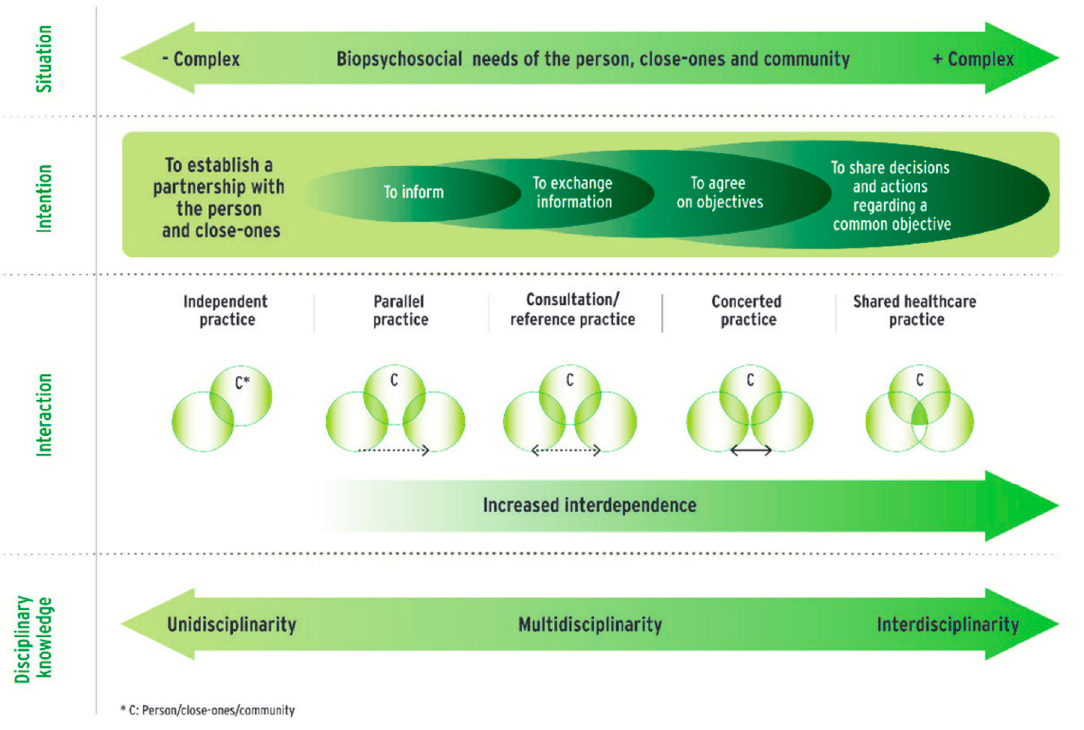
Figure 4. Continuum of Interprofessional Collaborative Practice in Health and Social Care [46]. + and − Complex indicators define the complexity of the needs of the person / close-ones / community and the biopsychosocial context in which these needs are to be